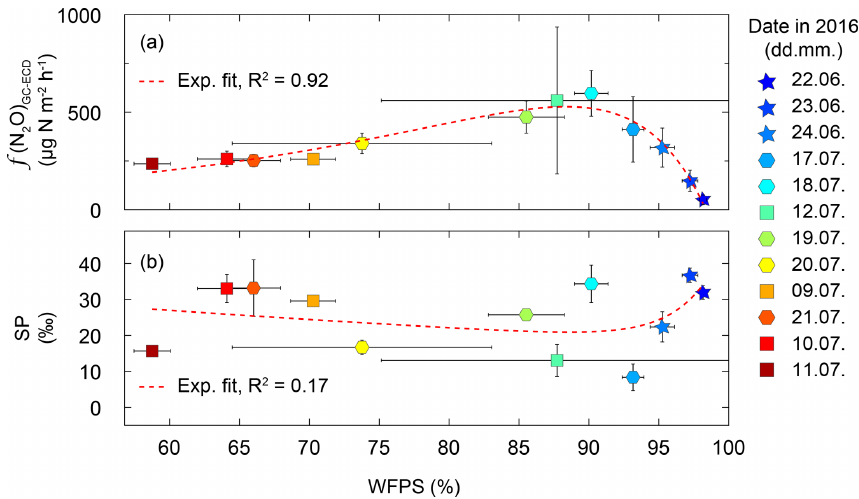
Figure 6. (a) Noon-to-noon average N 2 O flux rates f (N 2 O) versus water-filled pore space (WFPS) from the grassland site De-Fen. Indicated uncertainties represent variations in f (N 2 O) and WFPS within 1d. Results for individual chambers are given in Fig. S1. N 2 O fluxes were highest at 85%–92% WFPS. The red dashed line corresponds to a two-term exponential fit of the data shown here. (b) SP as a function of WFPS. Lowest SP values were found in the range of 85%–95% WFPS, which corresponds to the highest N 2 O fluxes. The red dashed line depicts a double exponential fit of the data shown here (this fit was not significant). The model used to fit the data corresponds to y = a · exp (b · x) + c · exp (d · x) (coefficients a , b , c , and d are given in the main